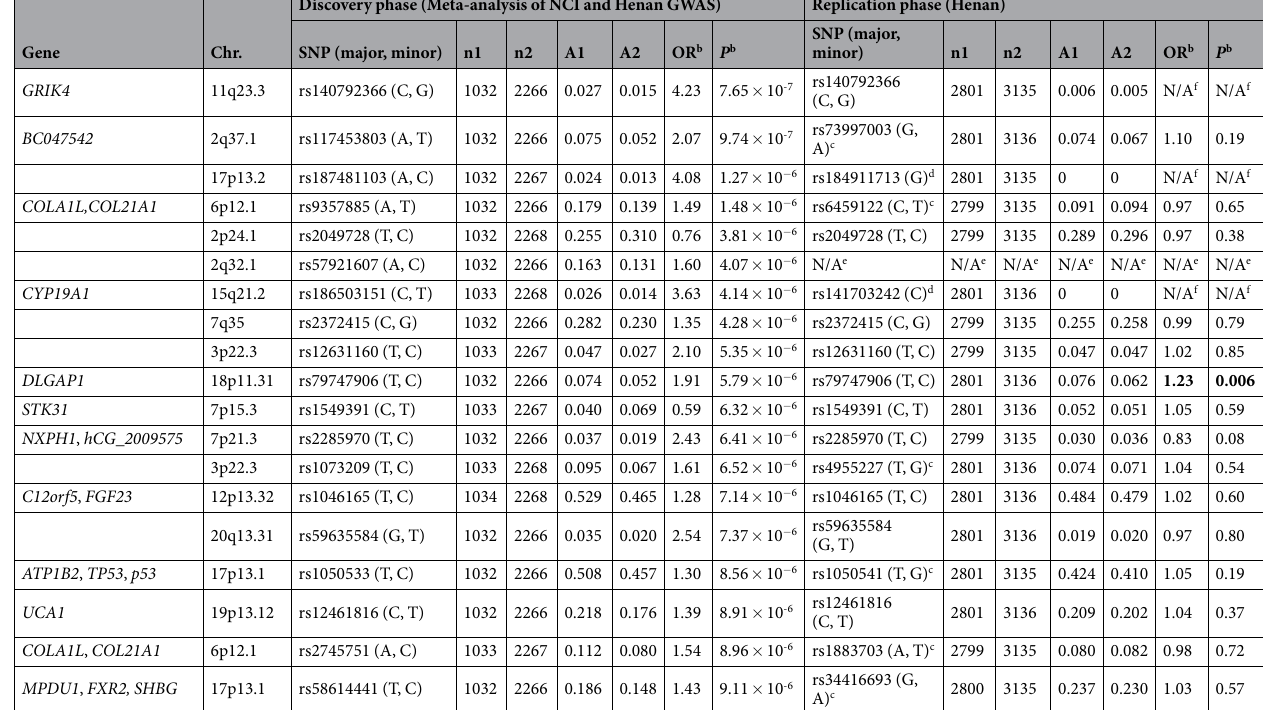
Table 2. Top SNPs in the NCI and Henan GWAS associated with family history of UGI cancer in ESCC cases a . a n1 is the number of cases with family history while n2 is the number of cases without family history. A1 is the allele frequency of the minor allele (effect allele) in cases with family history and A2 is the allele frequency of the minor allele (effect allele) in cases without family history. SNPs are ordered based on the increasing P - values in the discovery phase. b The P -values and ORs for the SNP (per one minor allele) were calculated from unconditional logistic regression models using genotype-trend tests adjusted for age, sex and sub-study (for the analysis of NCI study, which includes NCI Shanxi and NIT). c Surrogate SNPs were selected to replace the original SNP from the meta-analysis of the NCI and Henan GWAS. The surrogates were located within 200 kb on either side of each targeted SNP and were selected based on the r 2 with the targeted SNP in the genotype data from 1000 Genomes project JPT + CHB population. The linkage r 2 was 1.00 for rs73997003 with rs117453803, 0.62 for rs6459122 with rs9357885, 0.93 for rs4955227 with rs1073209, 0.58 for rs1050541 with rs1050533, 0.94 for rs1883703 with rs2745751, and 0.59 for rs34416693 with rs58614441. d For rs187481103 and rs186503151, we were unable to find good surrogates that could survive the assay design. Given the monoallelic nature of the tested surrogates (rs184911713 and rs141703242) in our study population, we were essentially unable to test/ replicate the findings for those two SNPs. e This SNP (rs57921607) and its surrogate(s) failed in the follow-up study. f ORs and P values not calculated because of the extremely rare minor